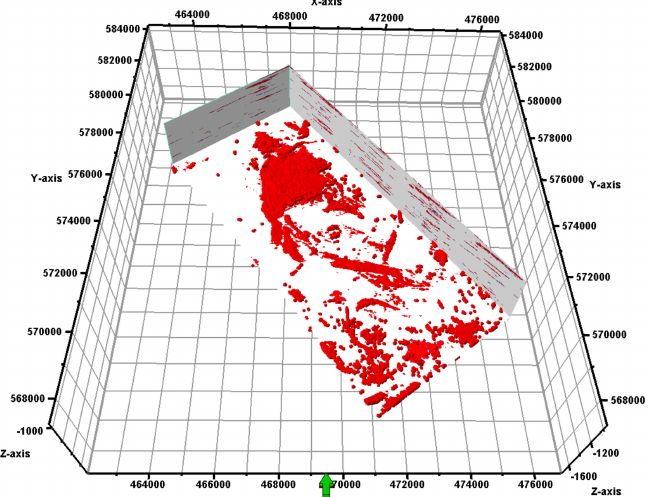
Figure 26. The predicted channel features on 3D